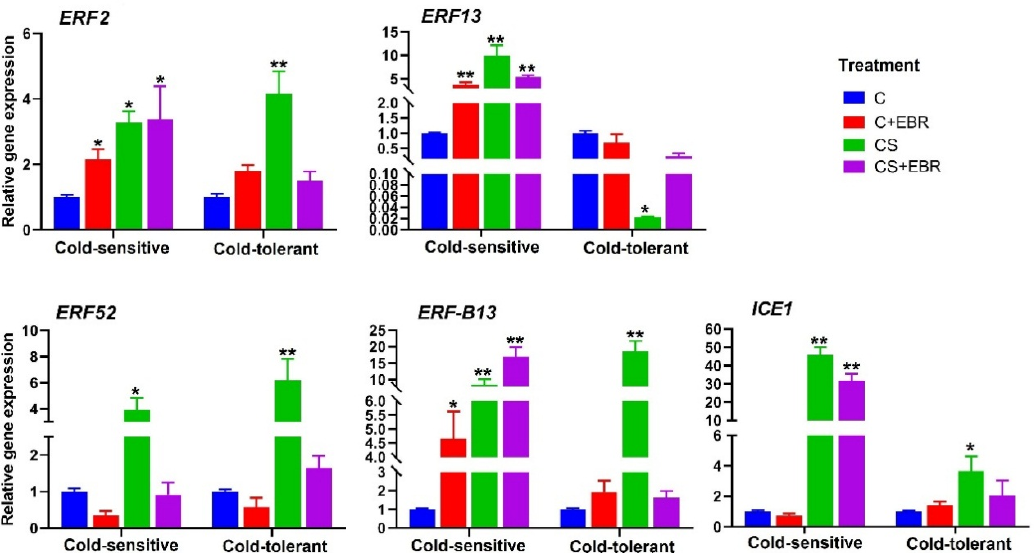
Figure 5. Expression patterns of studied genes under a low temperature (CS) and EBR treatment application; * and ** above a bar shows a significant difference between the applied treatments and normal temperature treatments as control (C) at p -value < 0.05 and p -value < 0.01, respectively (according to Student’s t -test).